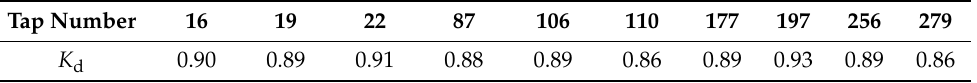
Table 5. Directionality factors K d (g) of typical taps in different building